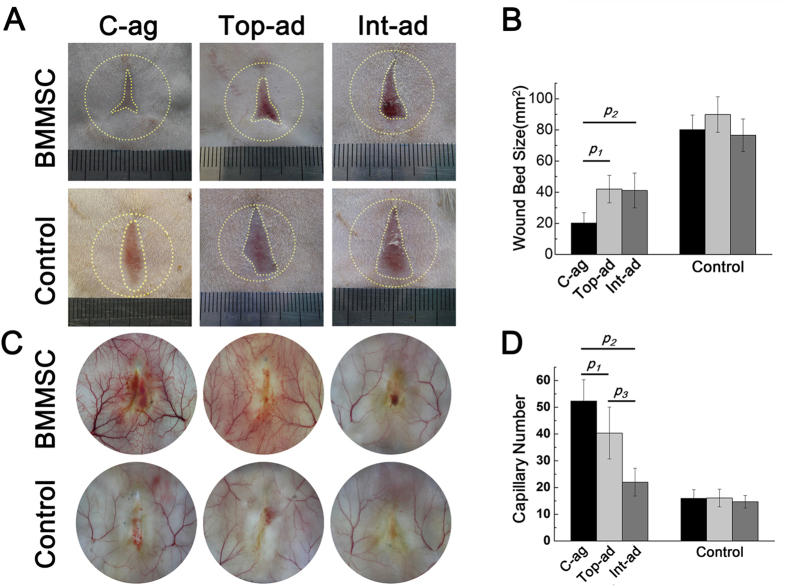
Wound bed size and vascularization state.(A,B) Wound bed size and vascularization state in BMMSC-transplanted rats with each control at 4-week post-operation. Yellow dashed circle outside and the dashed line inside showed the original wound size and the left wound bed respectively; (C) Quantification of wound bed size revealed that rats of C-ag group had the smallest wound bed left at 4W. p1 = 0.000, p2 = 0.001, n = 14; (D) Quantification of capillary number revealed that C-ag group models enjoyed the highest capillary density followed by models of Top-ad group and Int-ad group (p1 = 0.001, p2 = 0.000, p3 = 0.000, n = 15).